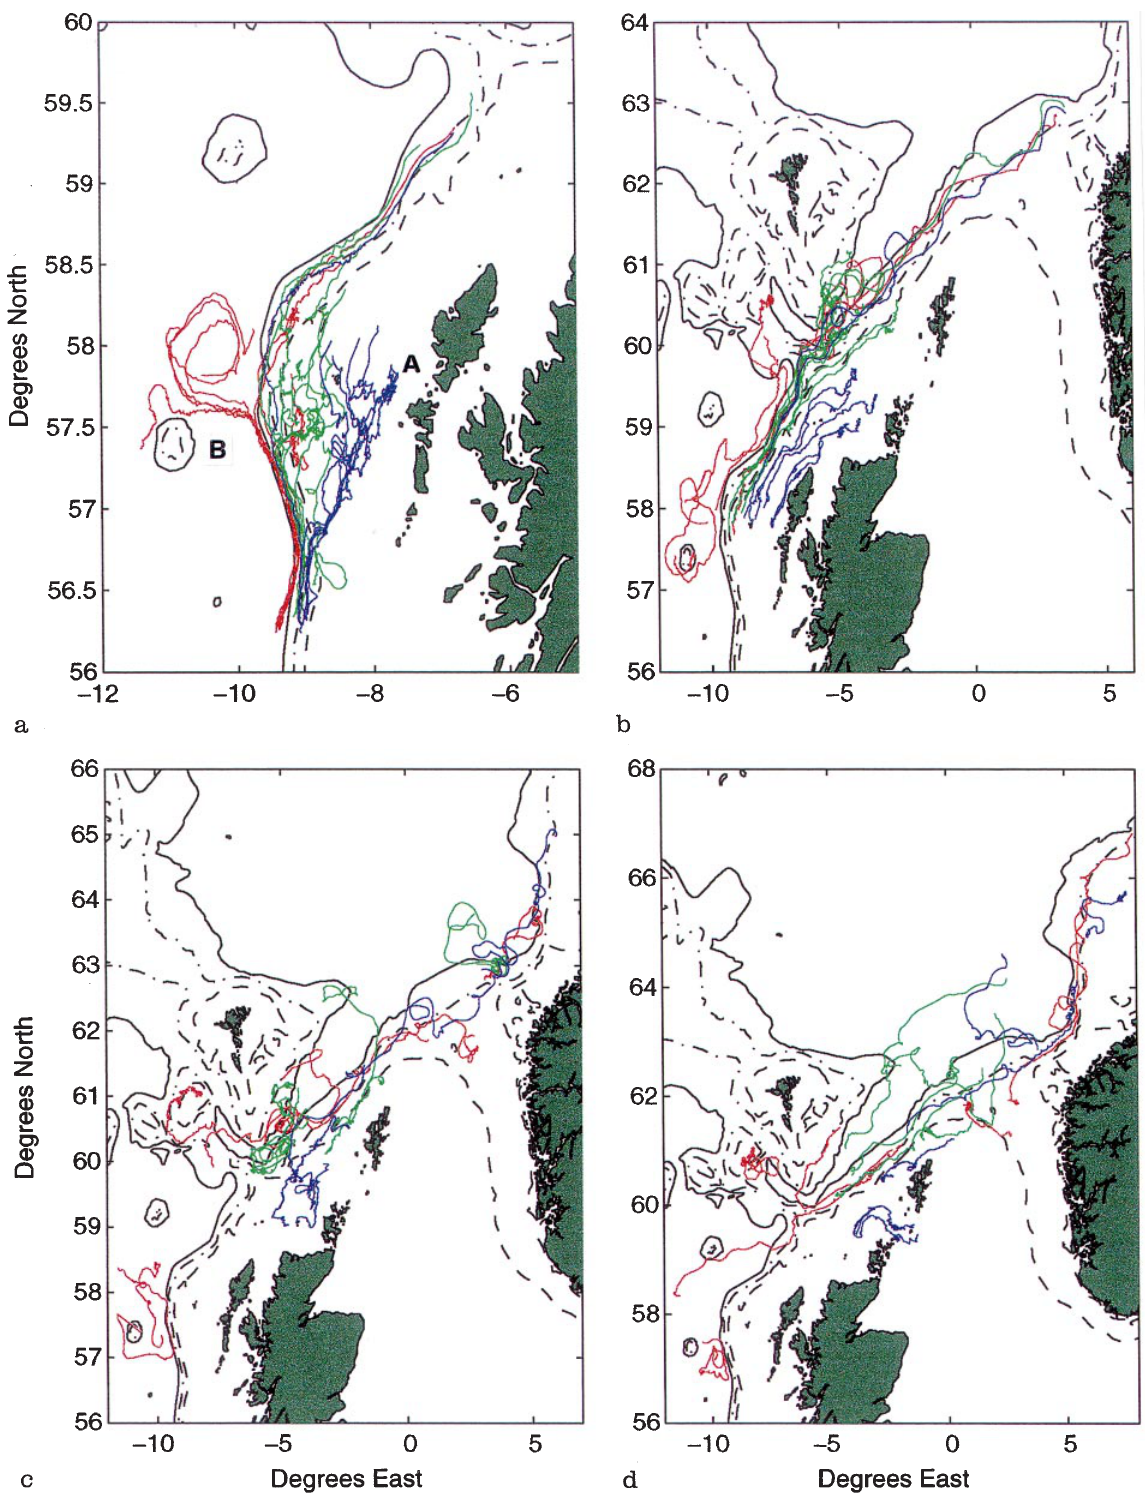
Fig. 3a–e. Drifter tracks after the winter deployment on 4 December 1995, in 25 day sections. Circle 1 drifters are blue , circle 2 green , and